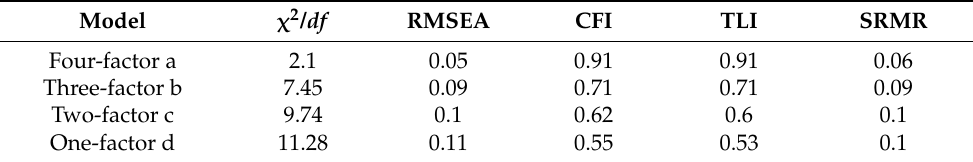
Table 1. Results of confirmatory factor analysis of the measurement models ( N =